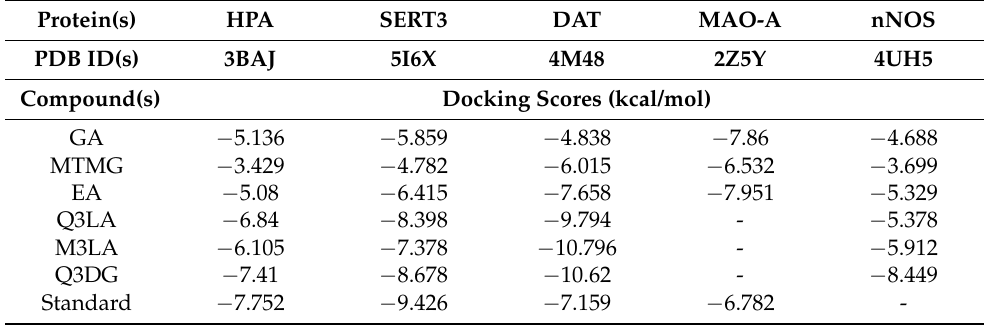
Table 4. Docking scores of the selected phenolic compounds from W. fruticosa leaves and reference standard drugs with HPA (PDB ID: 3BAJ) for antidiabetic activity and SERT3 (PDB ID: 5I6X),